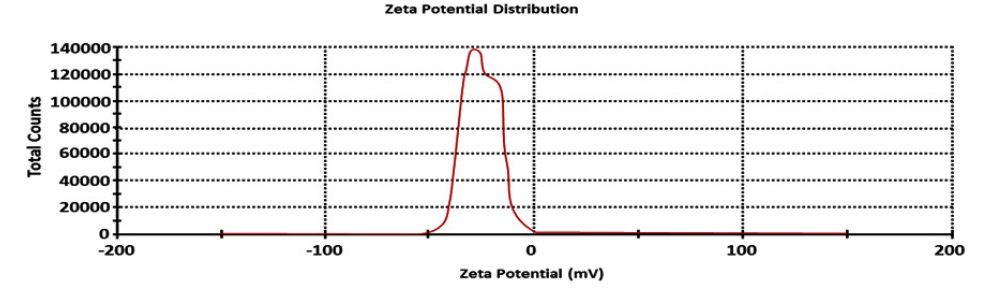
Fig. 4. Zeta potential of silver nanoparticles synthesized by Pseudomonas sp . H64